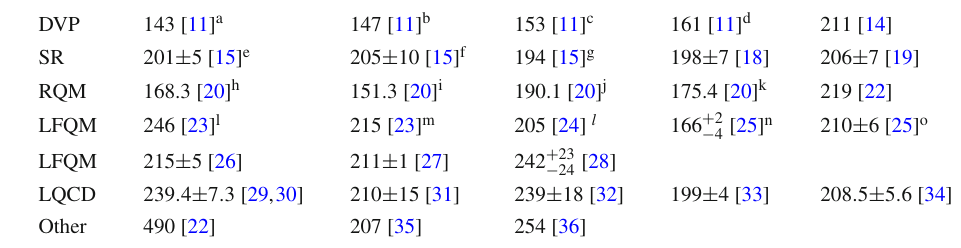
Table 1 Decay constant f ρ (in DVP the unit of MeV) obtained from the diffractive vector meson production using deep inelastic scattering (DVP), QCD sum rules (SR), relativistic quark model (RQM), light-front quark model (LFQM), lattice QCD (LQCD) and so on a With light-cone wave functions and parameters of Ref. [12] b With light-cone wave functions and parameters of Ref. [13] c With Gaussian wave functions and parameters of Ref. [12]. d With Gaussian wave functions and parameters of Ref. [13] e With nonlocal condensates like functions. f With Ball–Braun wave functions [16] g With Chernyak-Zhitnitsky wave functions [17] h With Gaussian spatial wave functions and adjusted parameters of Ref. [20] i With Gaussian spatial wave functions and parameters of Ref. [21] j With rational spatial wave functions and adjusted parameters of Ref. [20] k With rational spatial wave functions and parameters of Ref. [21] l With Coulomb plus linear potential model m With Coulomb plus harmonic oscillator potential model n With a dilation parameter κ = 0.54 GeV o With a dilation parameter κ = 0.68